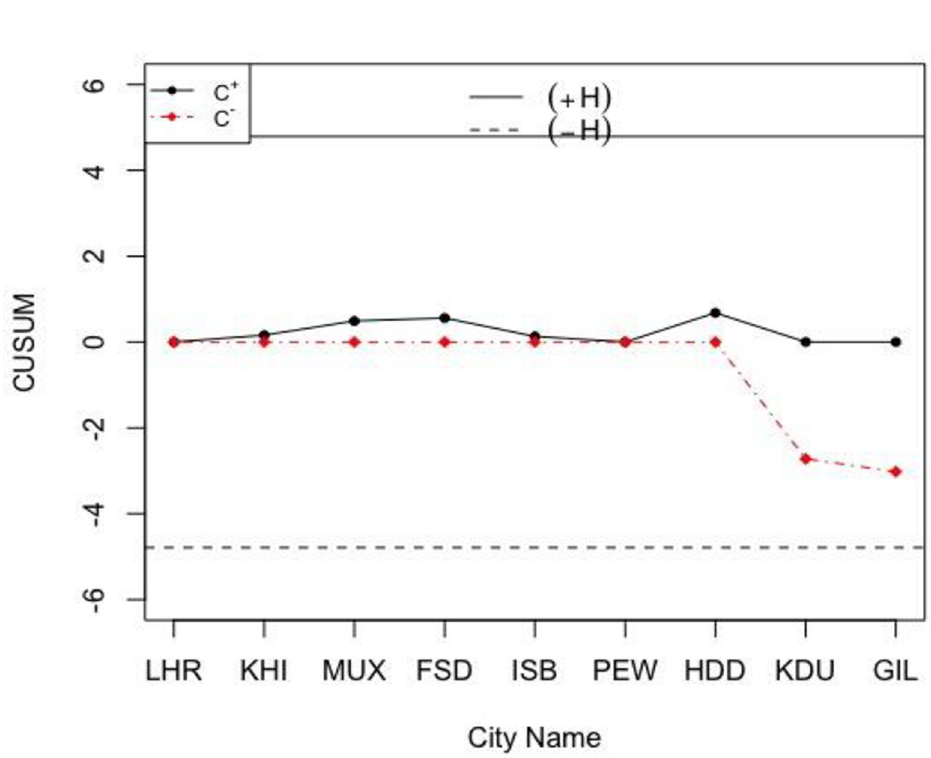
Fig 6. The classical CUSUM � X chart for the weather data with h = 4.791 and k = 0.5.